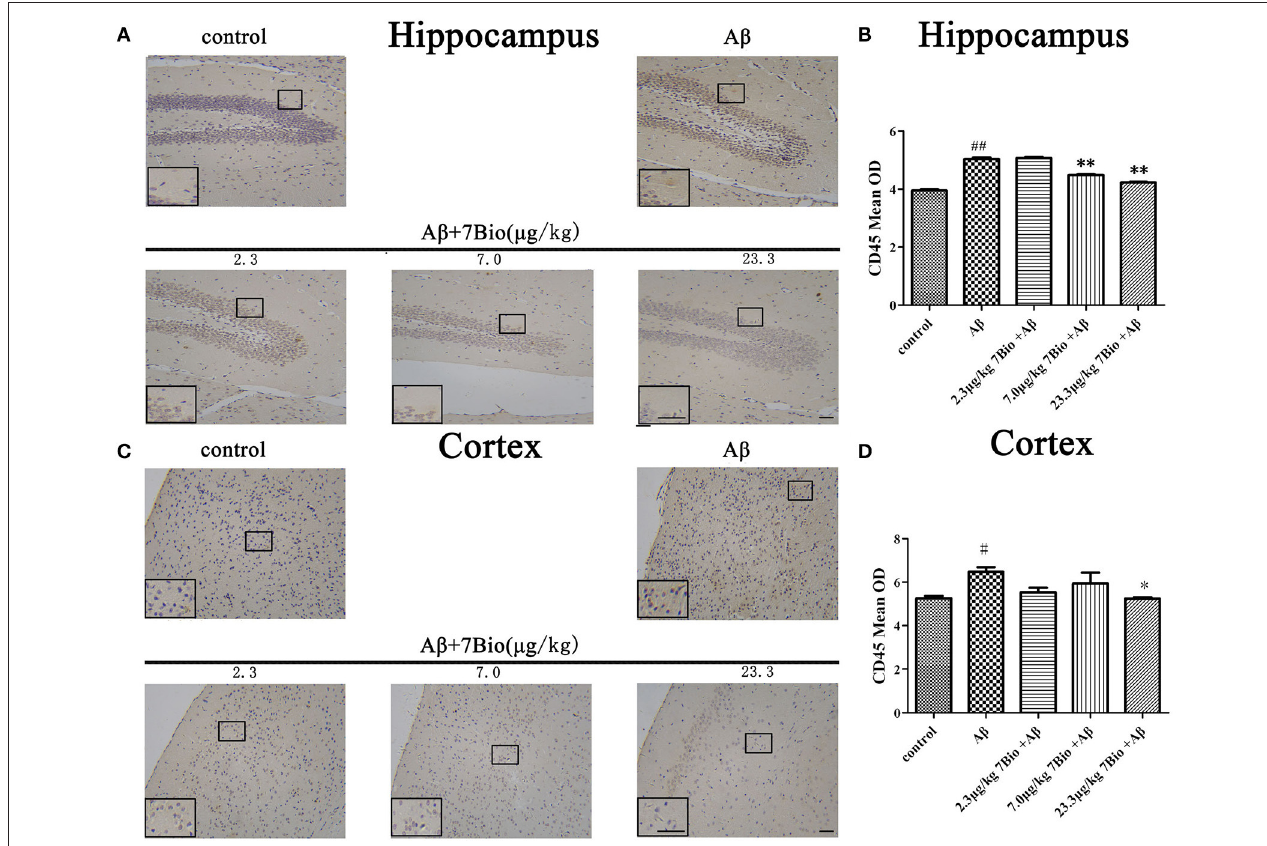
FIGURE 11 | 7Bio attenuates A β oligomer-induced increased of CD45 in the hippocampal and cortical region of mice. (A) Representative figures of IHC staining of CD45 in the hippocampal region in various groups as indicated. (B) Quantitative results showed that 7Bio decreased mean OD of CD45 in the hippocampal region of mice. (C) Representative figures of IHC staining of CD45 in the hippocampal region in various groups as indicated. (D) Quantitative results showed that 7Bio decreased mean OD of CD45 in the cortical region of mice. Data represent the mean ± SD ( n = 3); # p < 0.05 and ## p < 0.01 vs. control group, * p < 0.05 and ** p < 0.01 vs. A β group (one-way ANOVA and Tukey’s test). Scale bar: 30 µ